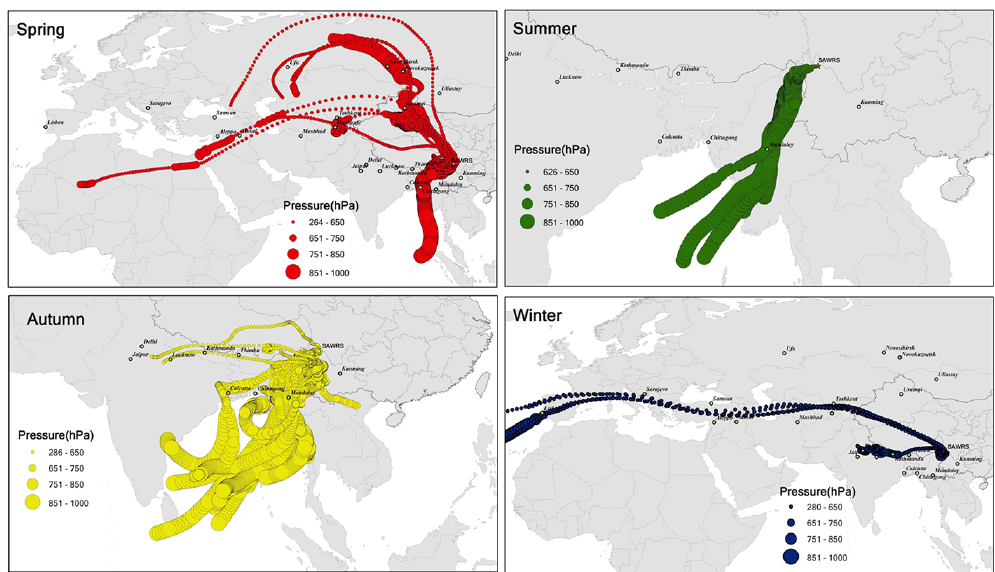
Figure 13. The back trajectories of the upper quartile of TGM observations at SAWRS for the four seasons. The air masses with high Hg were from South and Southeast Asia in summer and autumn, while some air masses with high Hg were from northwestern China. The rest of the air masses were from western Asia, central Asia and the Tibetan Plateau in spring and winter.